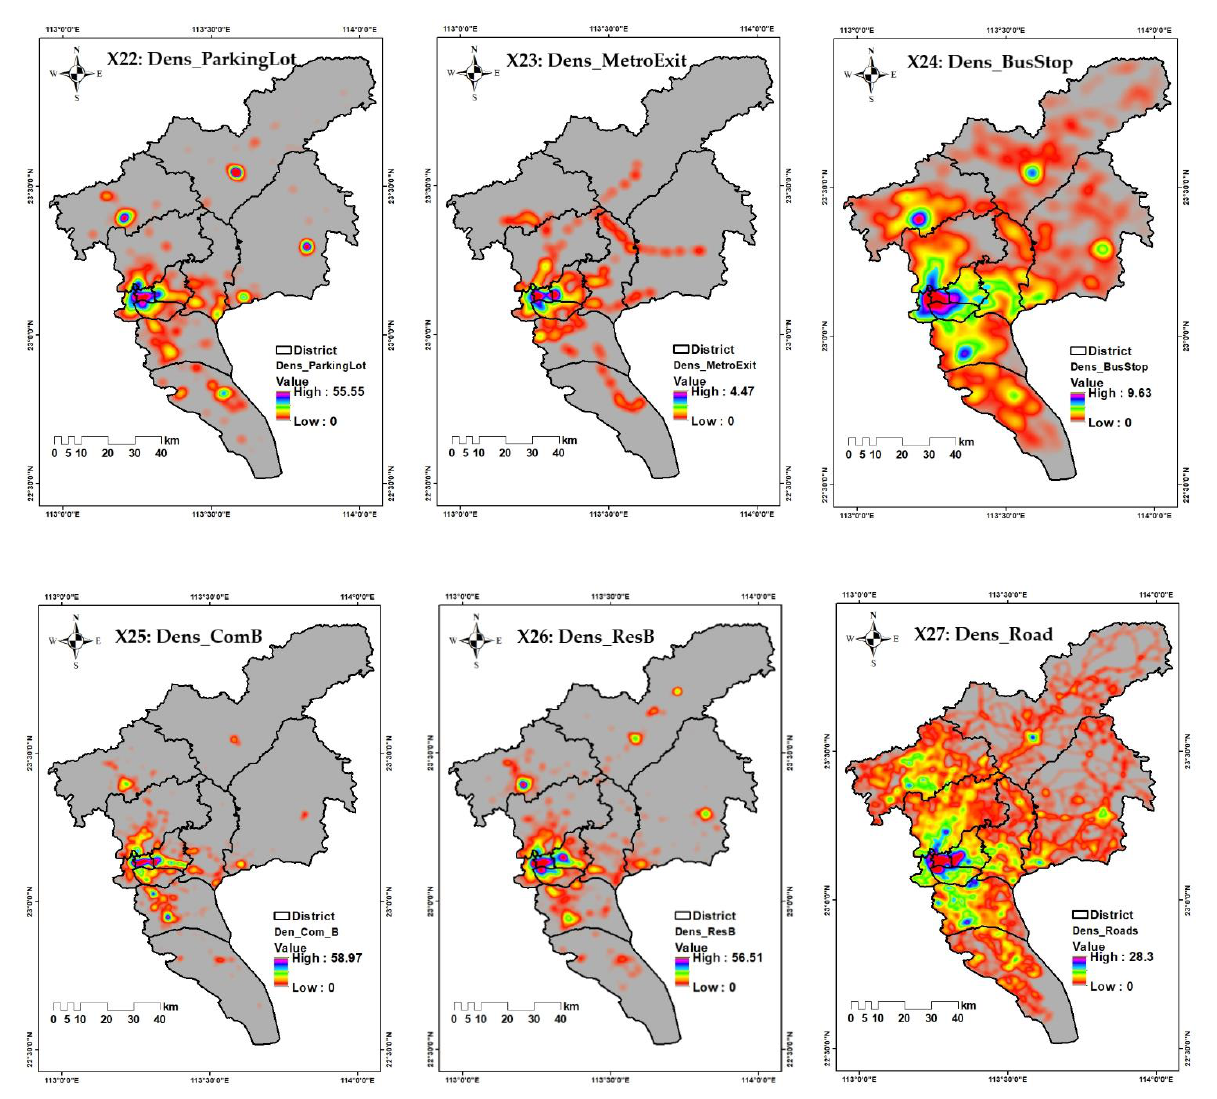
Figure 3. The distribution maps of the 27 candidate variables used in the model.